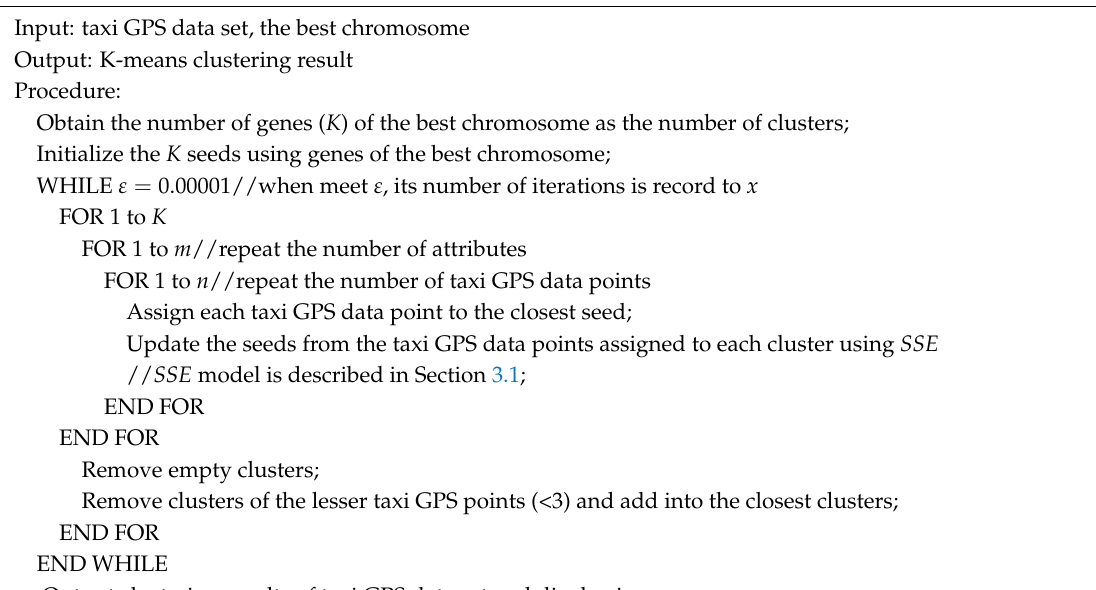
Algorithm 3. K-means clustering using the best